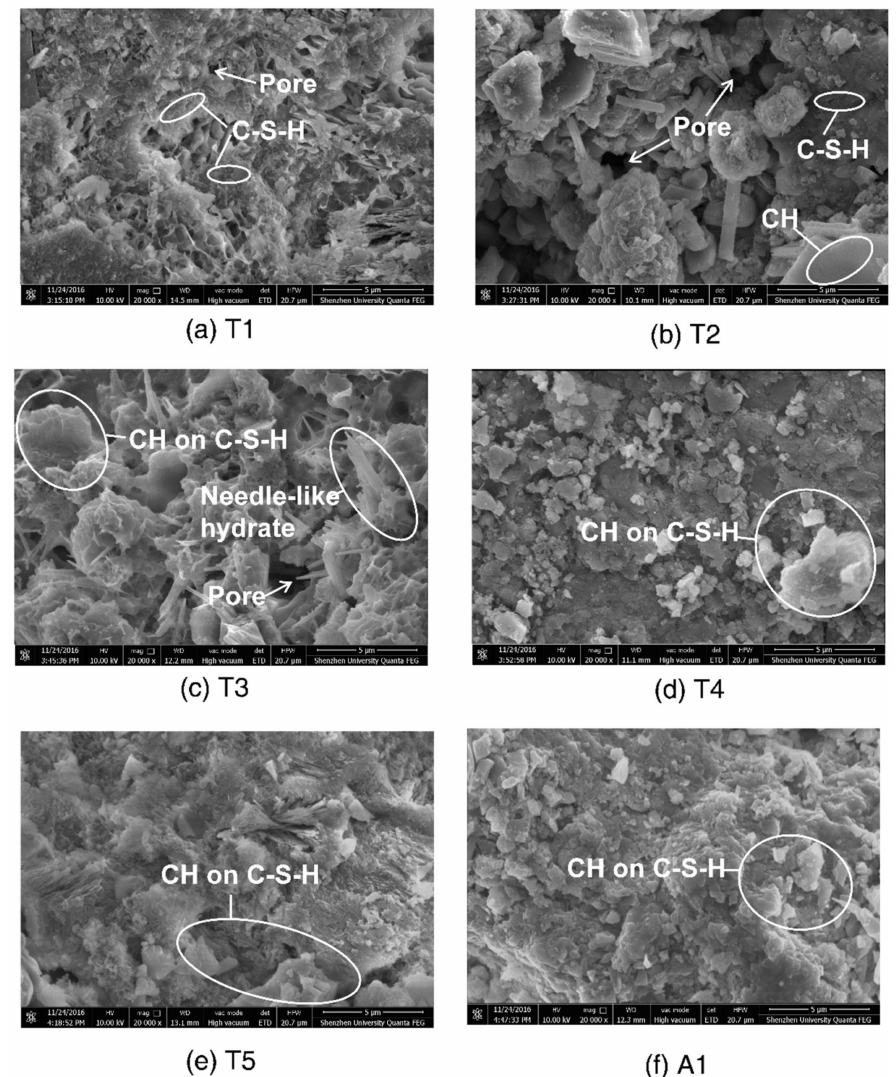
Figure 3. SEM micrographs of concrete samples from The atmospheric and tidal zones (magnification by 20,000 times): ( a ) T1; ( b ) T2; ( c ) T3; ( d ) T4; ( e ) T5; ( f ) A1.